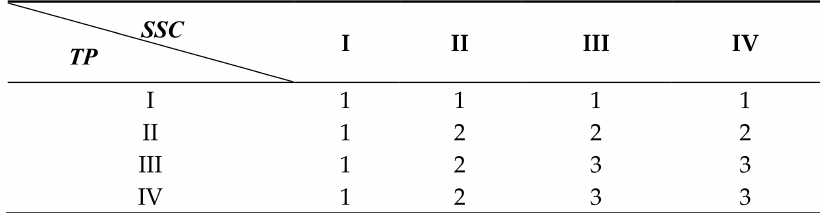
Table 1. Quality classes of stored berries based on total soluble solid content and total phenolic compounds.